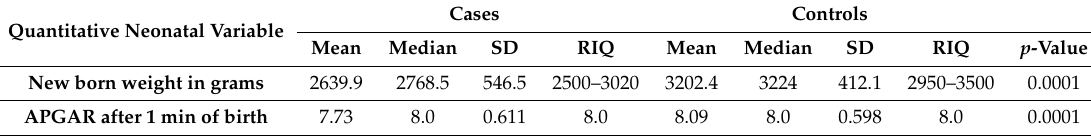
Table 6. Quantitative Neonatal variables in cases (186) and controls